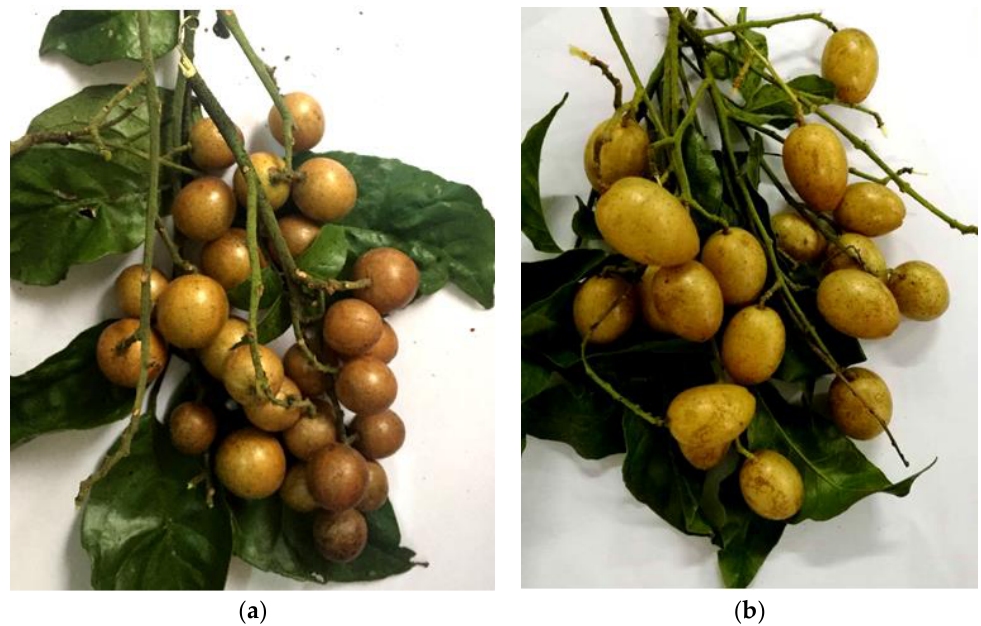
Figure 3. Leaves and ripe fruits of Hainan local wampee (HLW) ( a ) and chicken heart wampee (CHW) ( b ).